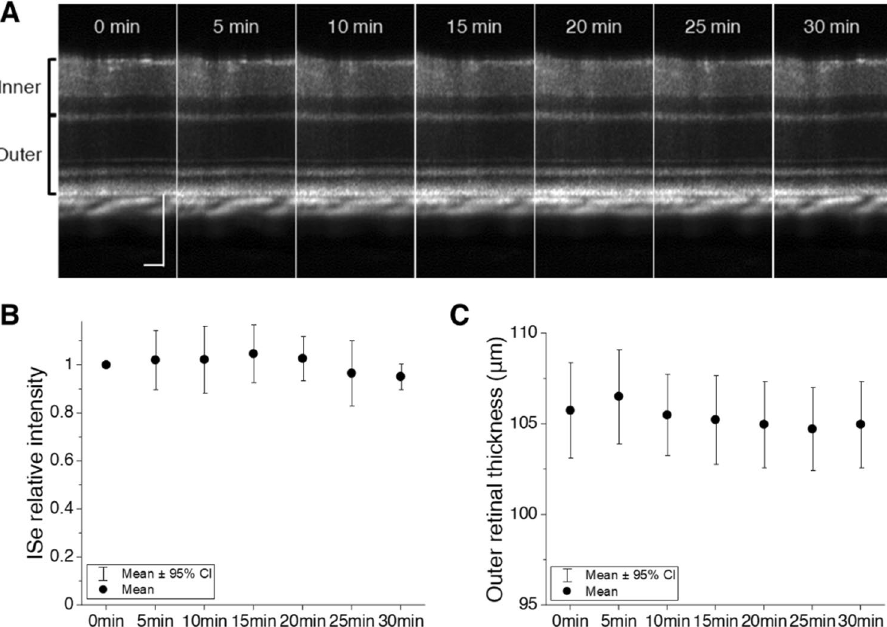
Figure 4. ( A ) Sequential OCT images obtained under ambient light conditions. ( B ) Relative OCT intensity measurement of the ISe band and ( C ) outer retinal thickness measurement under ambient light conditions. Data are represented as mean with 95% confidence intervals (error bars). N = 6. Scale bars: 100